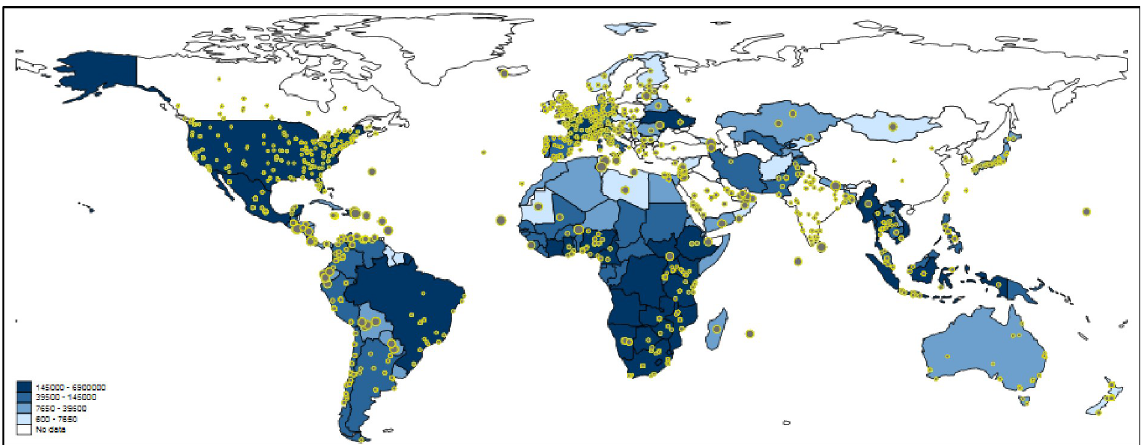
Fig 5. Tweeting on papers dealing with HIV worldwide. Each tweet is inversely weighted with the number of papers published by authors in the corresponding country: the larger the dots, the smaller the research activity. The countries are colored according to the total number of HIV cases. For some countries, e.g., Switzerland, no data are available. Some countries such as China or Iran block internet access to Twitter or its content (see section